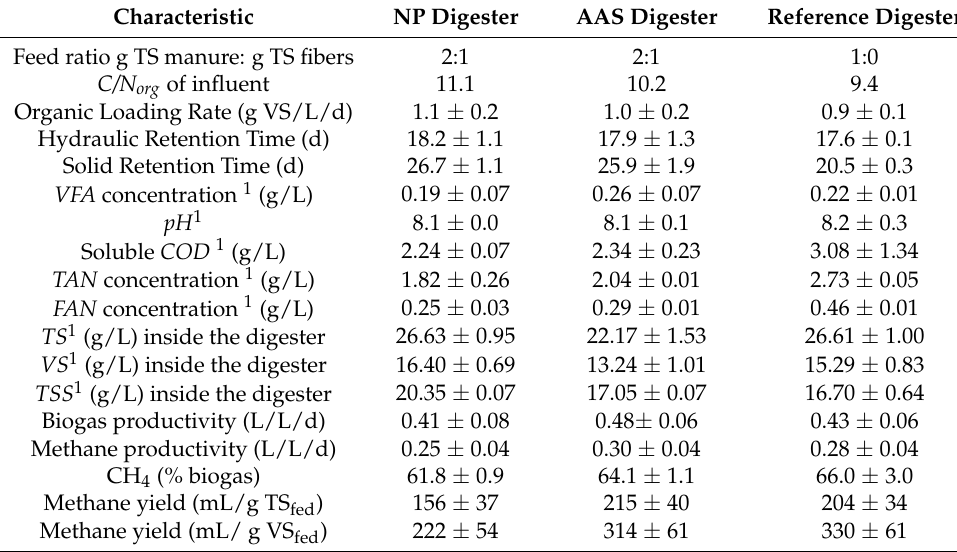
Table 2. Process characteristics of digesters during the period of 65–95 days of